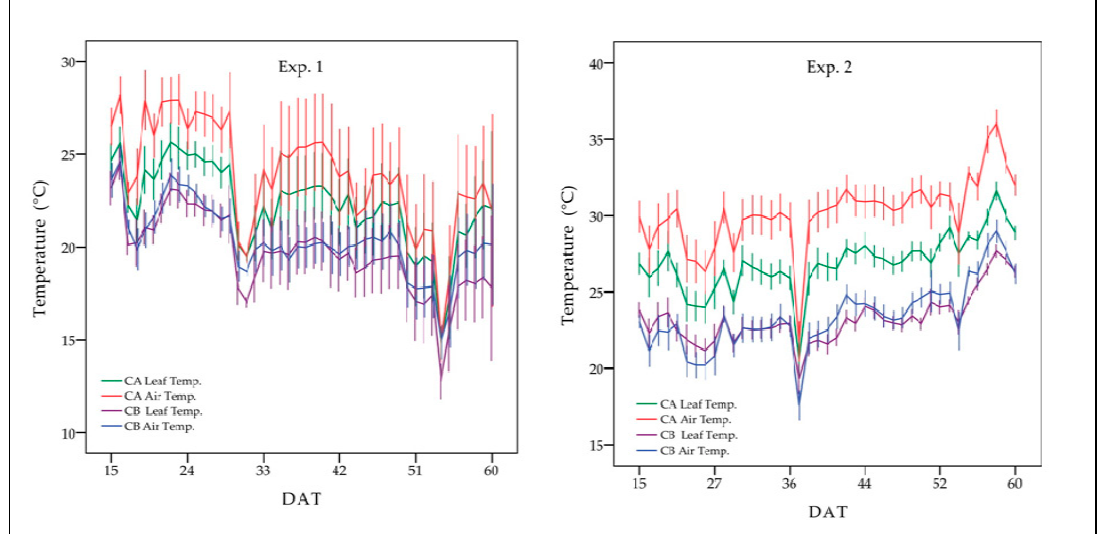
Figure 4. Mean measured greenhouse air and leaf temperature values in the greenhouse compartment with fan ventilation cooling system (CA) and in the greenhouse compartment with fan-pad evaporative cooling (CB) during Exp. 1 and Exp. 2, error bars (± 1 standard error).